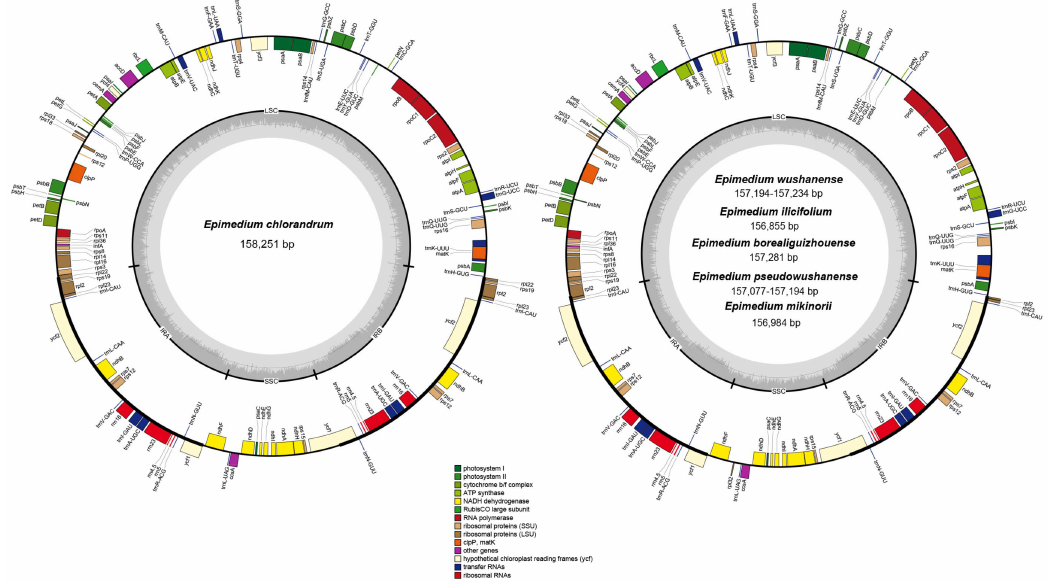
Figure 1. Gene map of the complete plastid genomes of E. wushanense and its closely related species. Genes drawn inside the circle are transcribed clockwise, whereas those outside are transcribed counterclockwise. The darker gray in the inner circle corresponds to the GC content, whereas the lighter gray corresponds to the AT